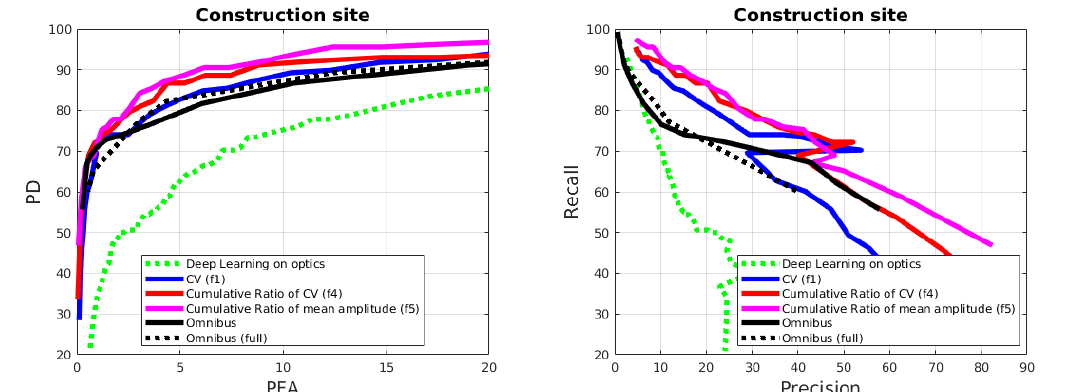
Figure 9. Case of construction site detection (Saclay site, France)—PD/PFA performances/Precision/ Recall